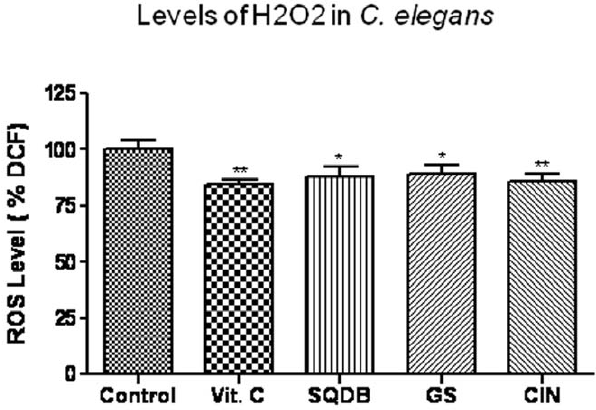
Figure 3. Intracellular levels of H 2 O 2 -related reactive oxygen species (ROS) in wild type C.elegans treated with SQDB, GS and CIN. Age-synchronized C. elegans , maintained and collected as described in Materials and Methods, were assayed at day 4 of age after treatment with vehicle (control), herbal formula SQDB (100 m g/ml), CIN, GS (10 m g/ml) or L-ascorbic acid (Vit.C 10 m g/ml) for 48 h. The worms were then analyzed for H 2 O 2 levels by incubation with 50 m M DCF-DA for 2.5 h, followed by measurement of fluorescent DCF production. Results are expressed as DCF fluorescence relative to untreated controls. *Statistically significant (independent t test, P , 0.05); **statistically significant (P , 0.01). Results are obtained from three independent experiments with a total of 300 worms.